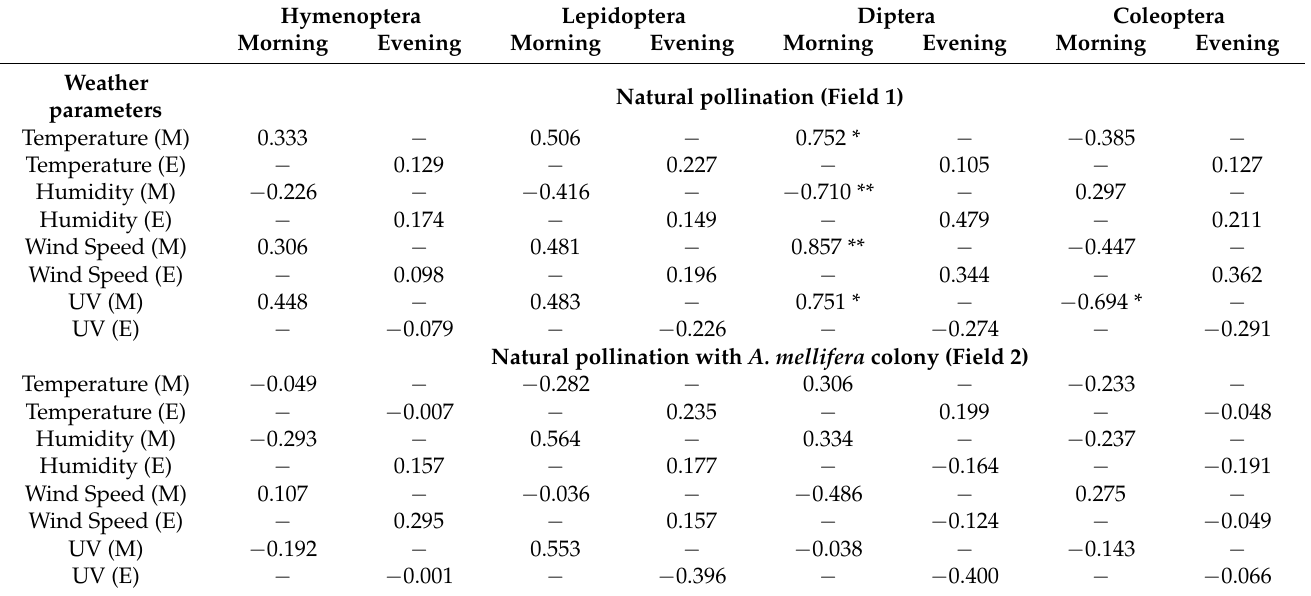
Table 2. Correlation coefficient (r) between insect pollinators/visitors and weekly weather parameters in Field 1 (Natural pollination) and Field 2 (Natural pollination with A. mellifera colony).